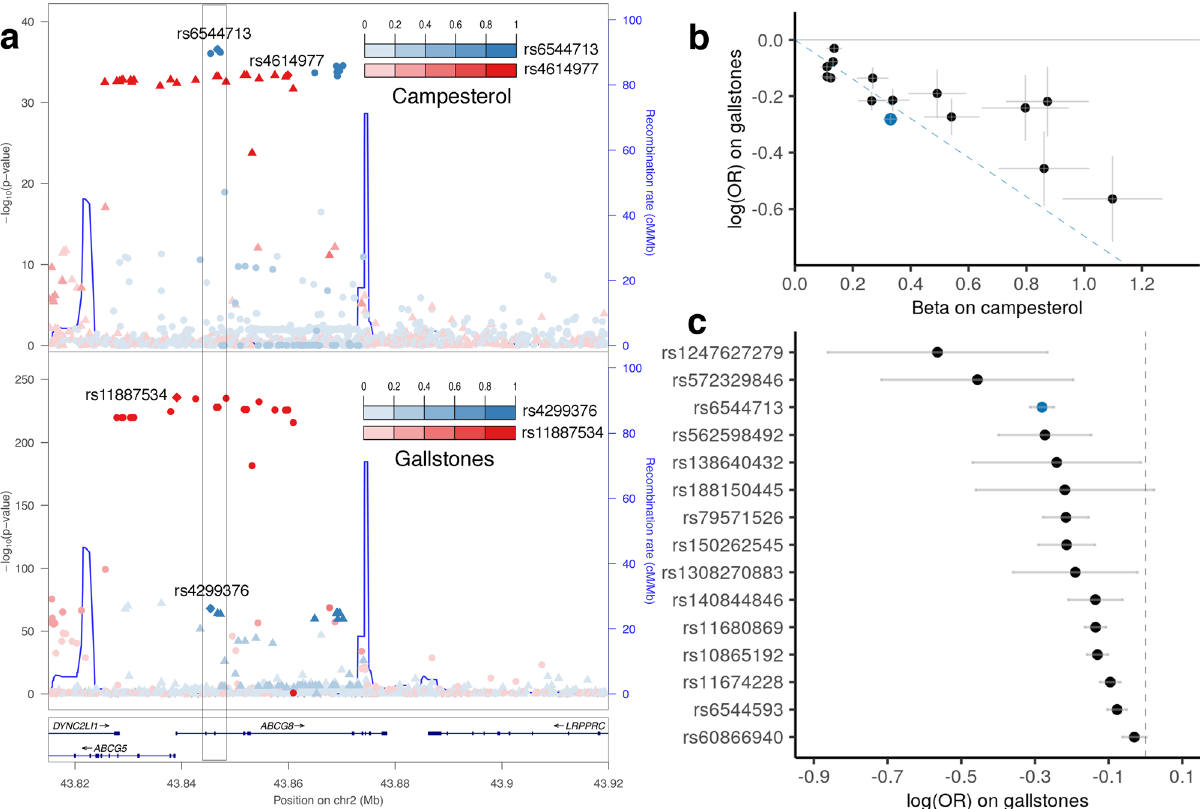
Fig. 5 Colocalization and causal relationship between campesterol and gallstones. a Stacked regional association plots for campesterol and gallstones (cholelithiasis, K11_CHOLELITH in FinnGen release 4) in the ABCG5/ABCG8 region. The index variants identi fi ed in stepwise conditional analysis (campesterol) and approximate conditional analysis (gallstones) are labeled and variants colored by their linkage disequilibrium (LD) to the index variant with which they are in strongest LD in METSIM. The campesterol signal (index variant rs6544713) is colocalized with the gallstone signal (rs4299376, pairwise LD r 2 = 0.993, RCP = 0.65) shown in the gray box. In contrast, no colocalization was detected between the signals indexed by rs4614977 and rs11887534. No coding variants within 1 Mb have LD r 2 > 0.2 with rs6544713 in METSIM. b Comparison of effect sizes for the 15 instrumental variables genome-wide without signi fi cant heterogeneity ( P > 0.05) used in Mendelian randomization analysis between campesterol and gallstones. rs6544713 is in blue. The slope of the blue dashed line depicts the estimated causal effect size of campesterol on gallstones. The Egger regression intercept is deemed not signi fi cant ( P = 0.15). c Negative relationship between instrumental variable and risk of gallstones. OR: odds